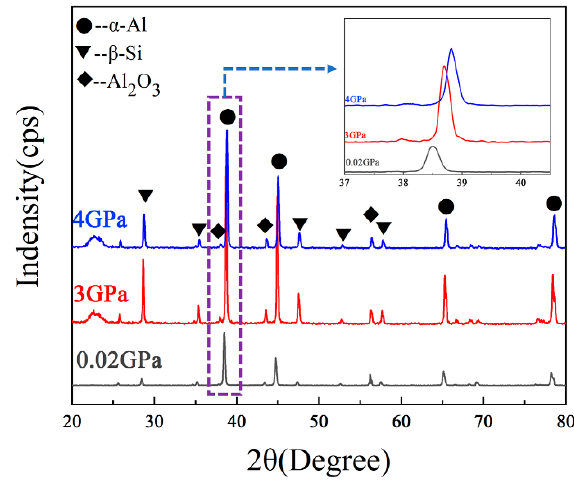
Figure 1. X-ray diffraction (XRD) pattern of Al 2 O 3 /Al-20Si composite.